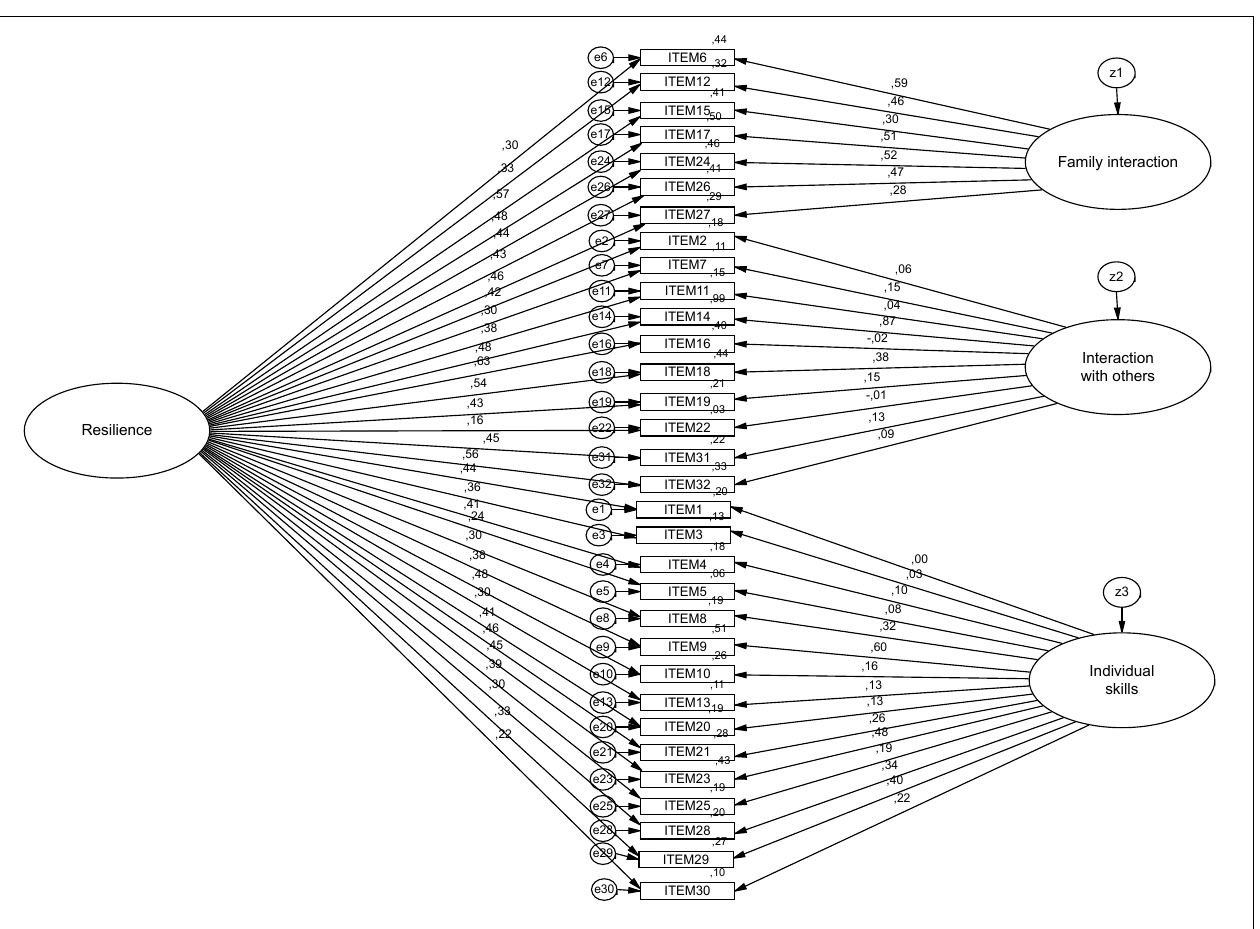
FIGURE 3 | Standardized estimates, as well as the squared multiple correlations for Model 2-CFA.